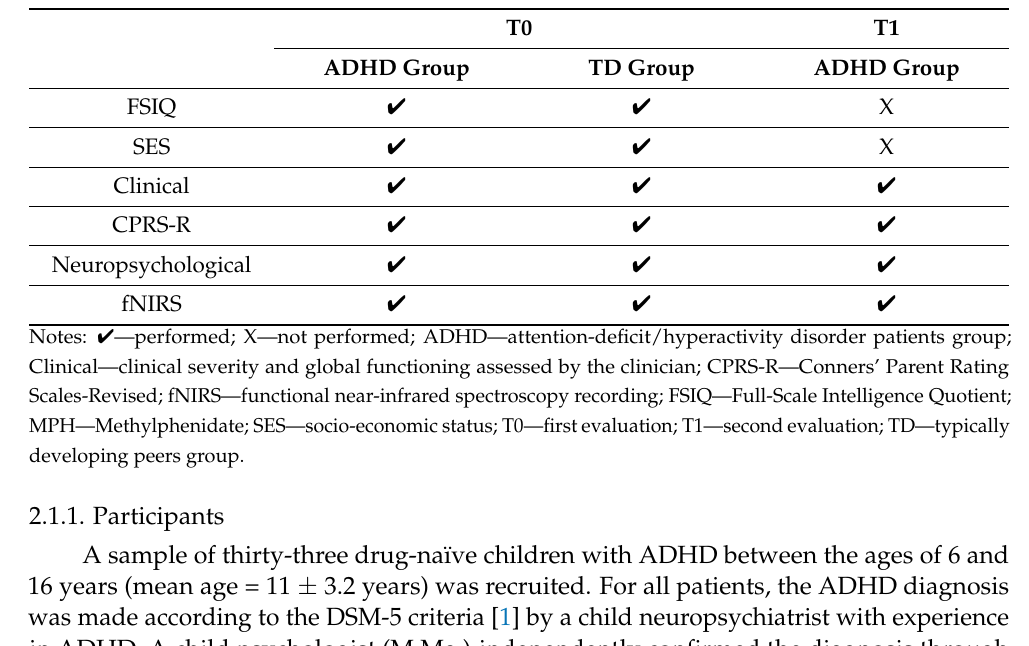
Table 1. Study Design. The evaluations were performed before (T0) and after (T1, for the ADHD group) MPH